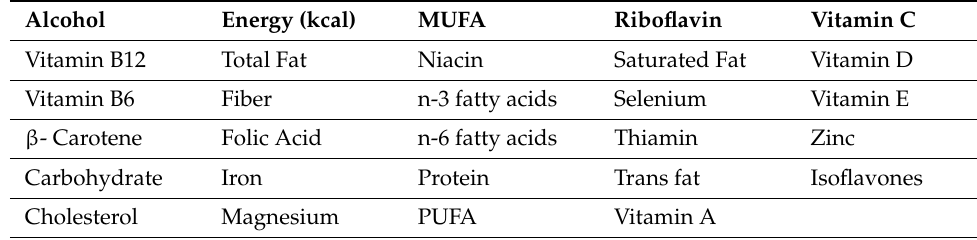
Table 1. DII components available for calculation of the DII score * [9]. Alcohol Energy (kcal)